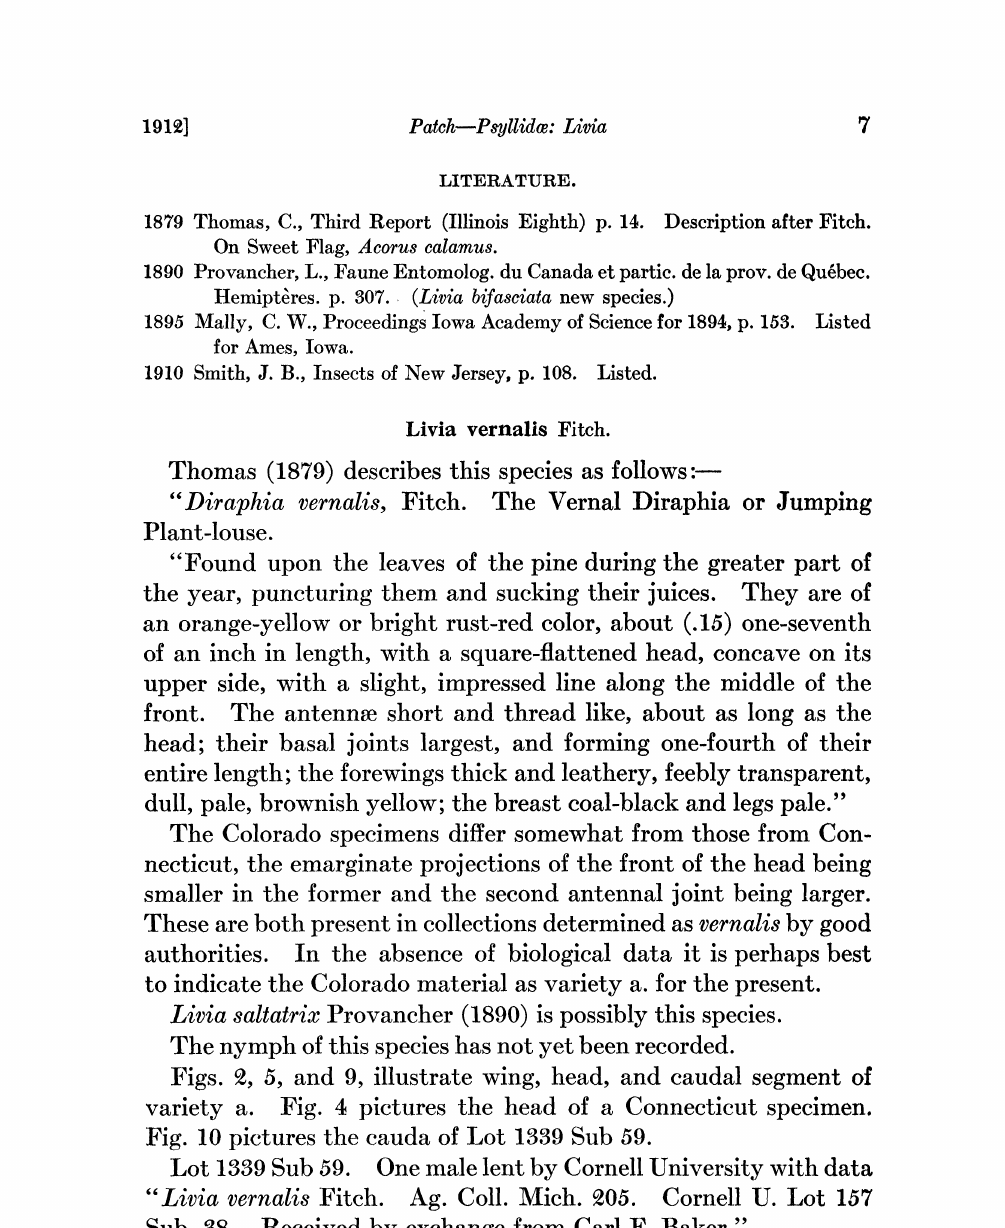
Fig. 4 pictures the head of a Connecticut specimen. Fig. 10 pictures the cauda of Lot 1339 Sub